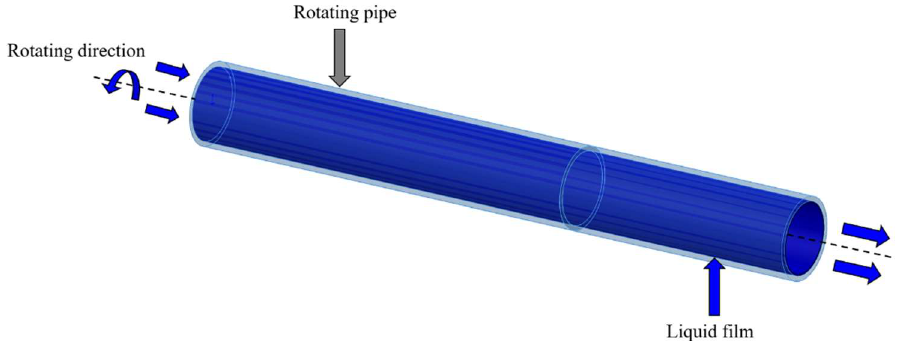
Figure 1. The schematic liquid film inside an axially rotating pipe.